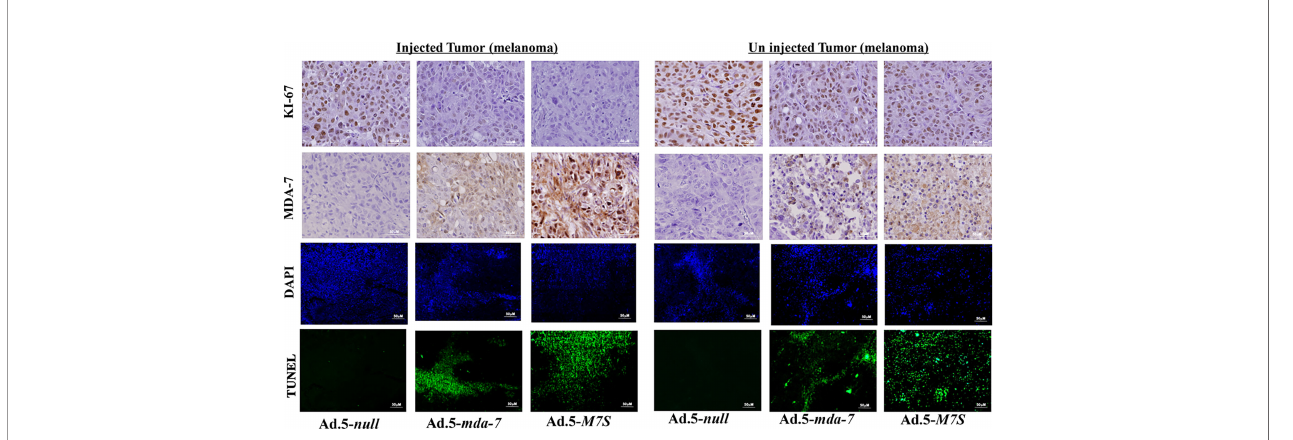
FIGURE 6 | Immunohistochemical analysis of melanoma xenograft tumors injected with Ad.5- mda-7 or Ad.5- M7S . At the end of the experiment, tumor tissues were excised and fi xed in 10% formalin. IHC analysis of MDA-7/IL-24 and Ki-67 in representative tumor sections from the melanoma xenograft tumors (from Figure 5A ) are shown. Sections were immuno-stained by TUNEL to determine apoptosis and DAPI for nuclear staining. Representative photographs are presented from each experimental group. Left panels show the injected tumors, while the right panels show the un-injected tumors.